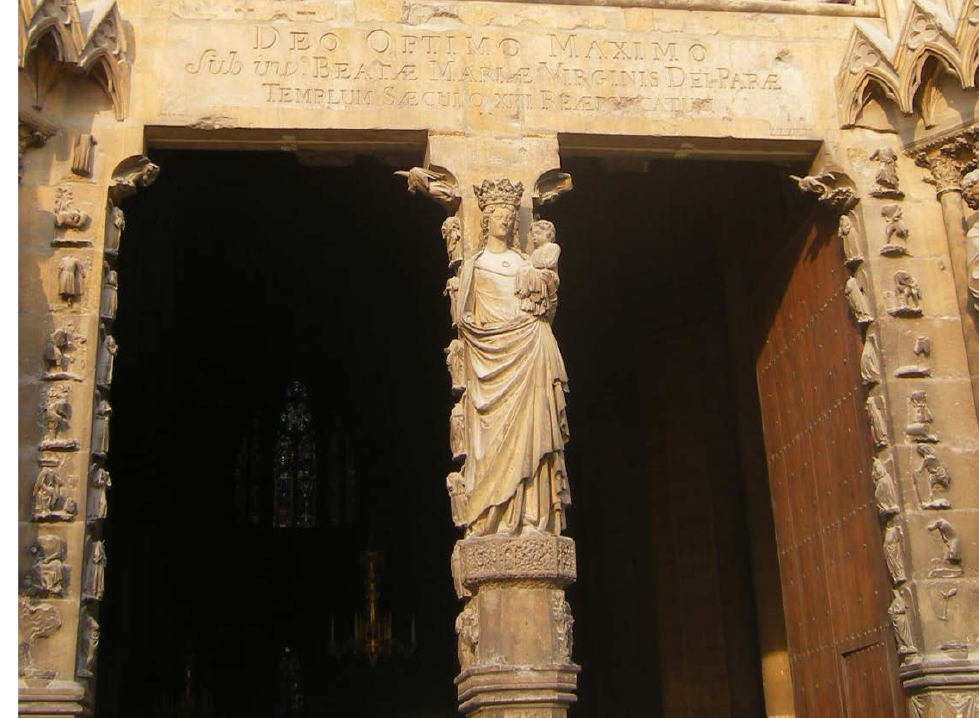
Figure 7. Reims Cathedral, Mullion of the central portal of the West façade, c. 1260–70.